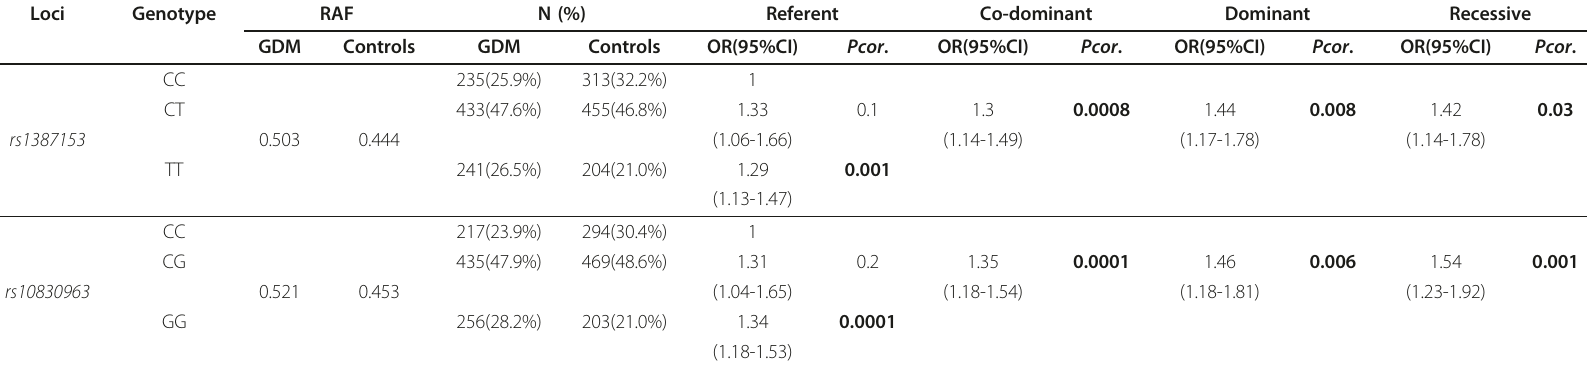
Table 2 Allele and genotype distributions of MTNR1B polymorphisms in GDM and control